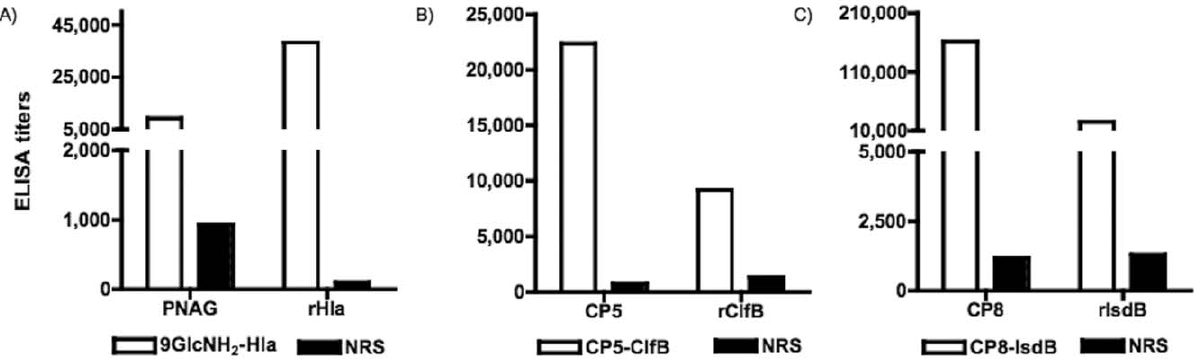
Figure 1. Immune response of rabbits immunized with 9GlcNH 2 -Hla, CP5-ClfB and CP8 IsdB conjugate vaccines. (a) ELISA titers to PNAG and recombinant Hla protein. (b) ELISA titers to CP5 and recombinant ClfB protein. (c) ELISA titers to CP8 and recombinant IsdB protein. Sera were obtained from rabbits immunized with two subcutaneous doses of the conjugate vaccines equivalent to 10 m g of carbohydrate and three I.V. doses corresponding to 7.5 m g of carbohydrate.